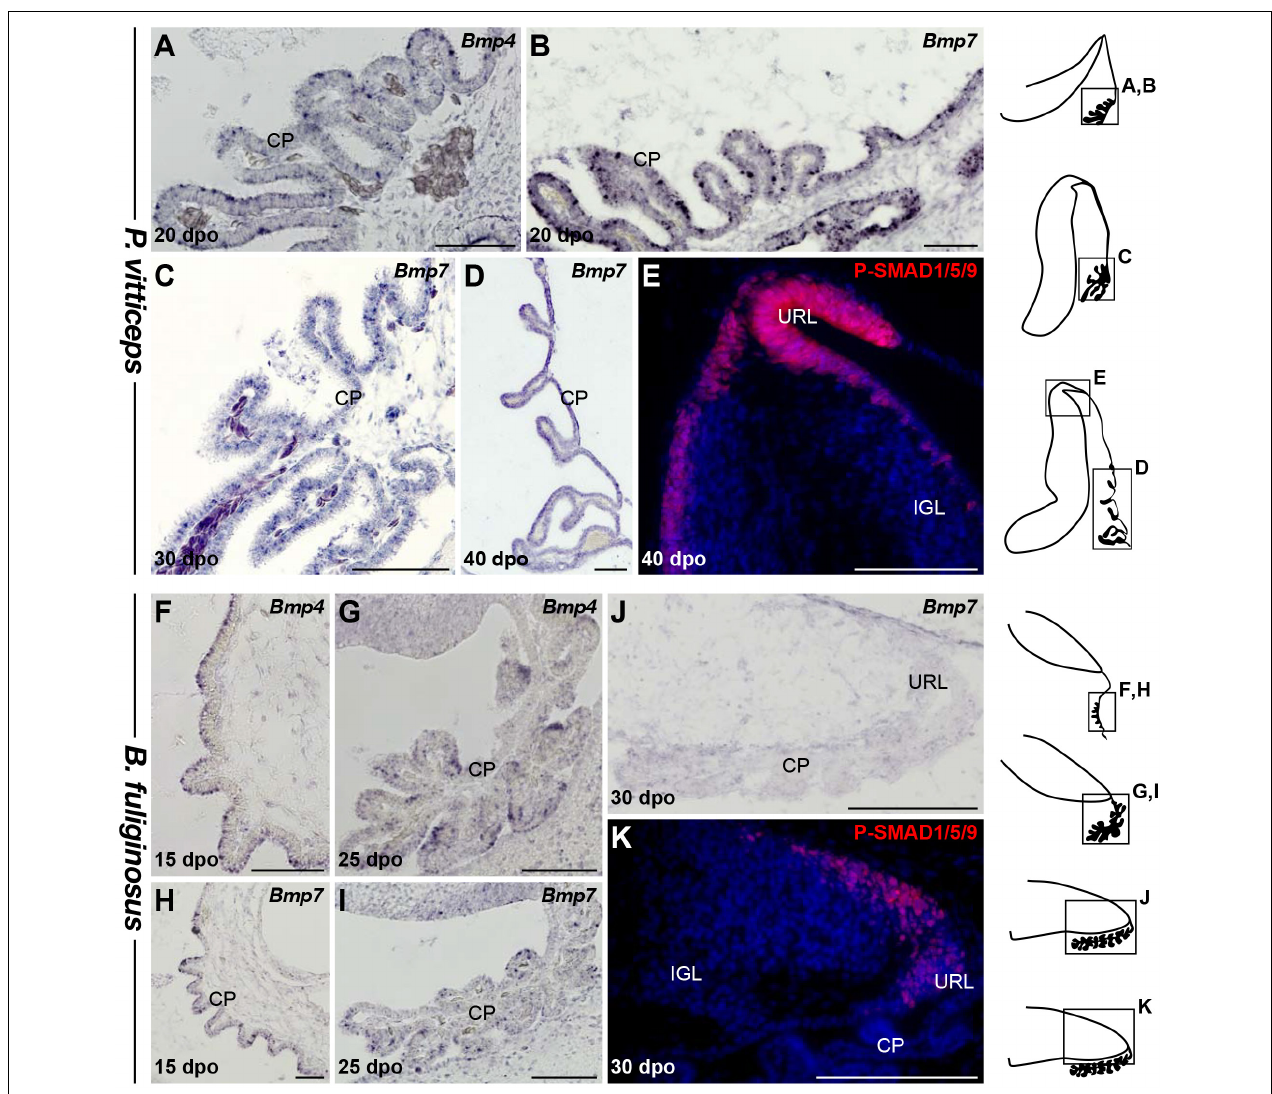
FIGURE 6 | Characterization of BMP signaling pathway during early cerebellogenesis in P. vitticeps and B. fuliginosus . (A–D) ISH showing the expression of Bmp4 (A) or Bmp7 (B–D) at various indicated embryonic developmental stages in non-neural tissues bordering the cerebellum of P. vitticeps . (E) IHC for P-SMAD1/5/9 in the dorsal part and URL region of P. vitticeps cerebellum at 40 dpo. (F–I) ISH showing the expression of Bmp4 (F–J) or Bmp7 (H–J) at various indicated embryonic developmental stages in non-neural tissues bordering the cerebellum of B. fuliginosus . (K) IHC for P-SMAD1/5/9 (red staining) in the caudal part and URL region of B. fuliginosus cerebellum at 30 dpo. IGL, internal granule layer; URL, upper rhombic lip; CP, choroid plexus. Scale bars: 100 µ